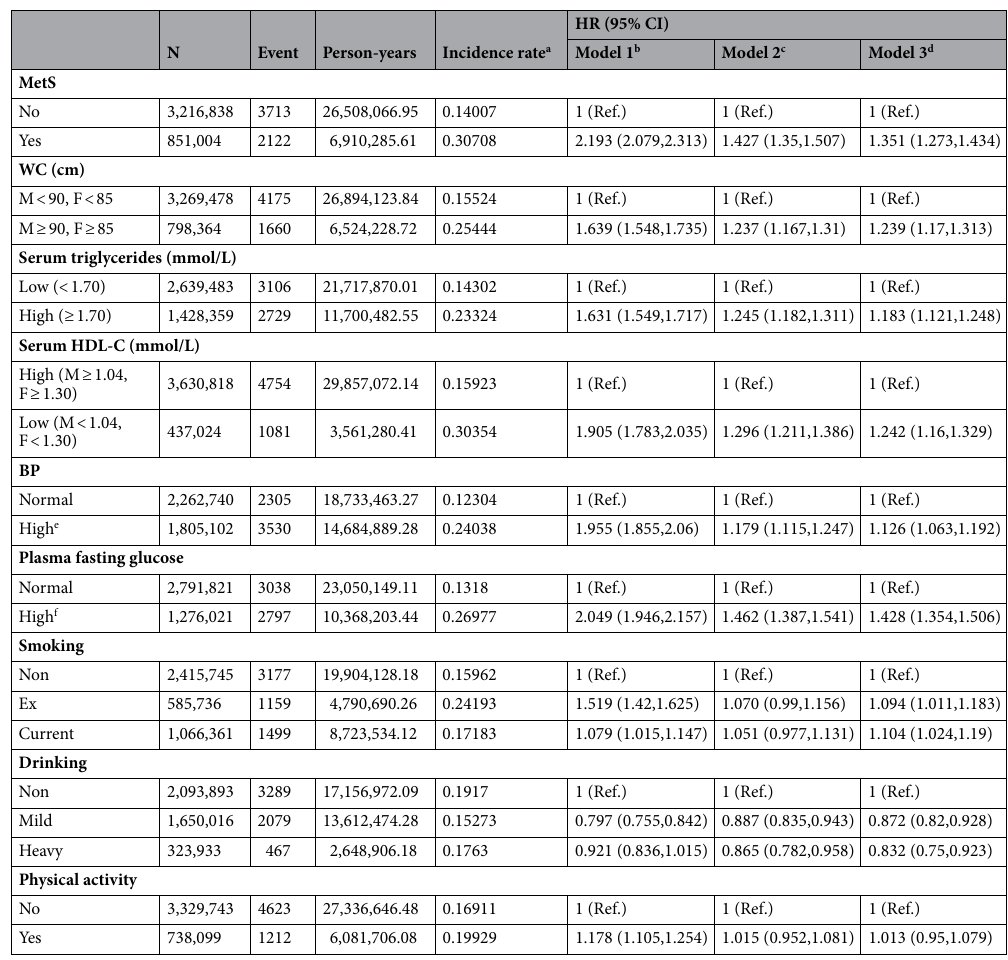
Table 2. Risk of ocular motor cranial nerve palsy according to the presence of metabolic syndrome and its components. N number, HR hazard ratio, CI confidence interval, MetS metabolic syndrome, WC waist circumference, M males, F females, HDL-C high-density lipoprotein cholesterol, BP blood pressur. a Ocular motor incidence per 1,000 person-years. b Model 1 was unadjusted. c Model 2 was adjusted for age and sex. d Model 3 was adjusted for age, sex, smoking status, alcohol consumption, and physical activity. e Systolic BP ≥ 130 mmHg, diastolic BP ≥ 85 mmHg, or treatment with antihypertensive agents. f Plasma fasting glucose ≥ 5.55 mmol/L or the use of hypoglycemic